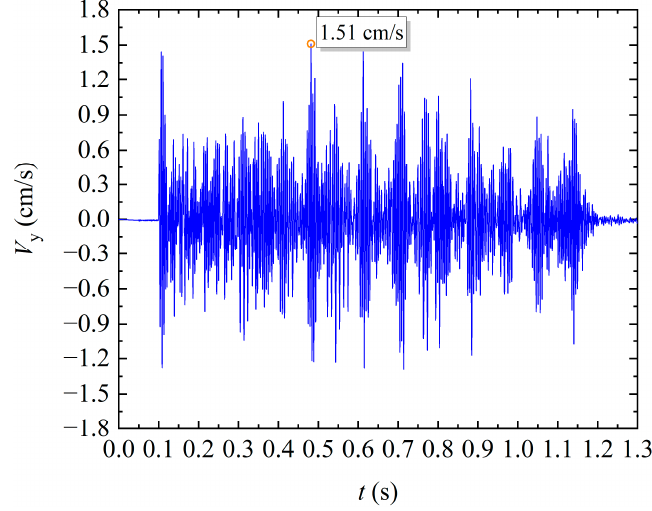
Figure 5. Blasting vibration velocity waveform of tunnel electronic detonators.